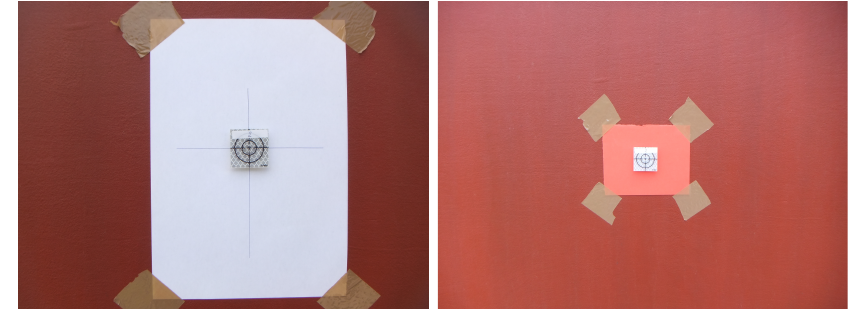
Figure 17. Different targets used in the registration benchmark tests B1 ( left ) and B2 ( right